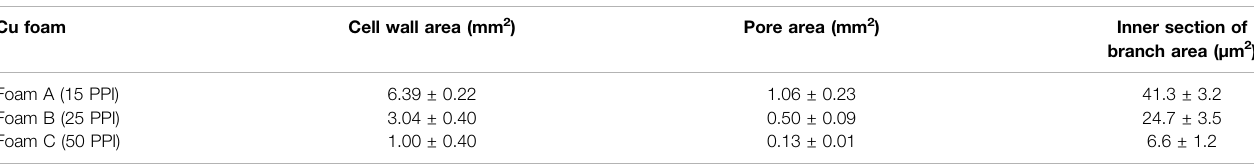
TABLE 1 | Size of Cu foam for (A) foam A, (B) foam B, and (C) foam C